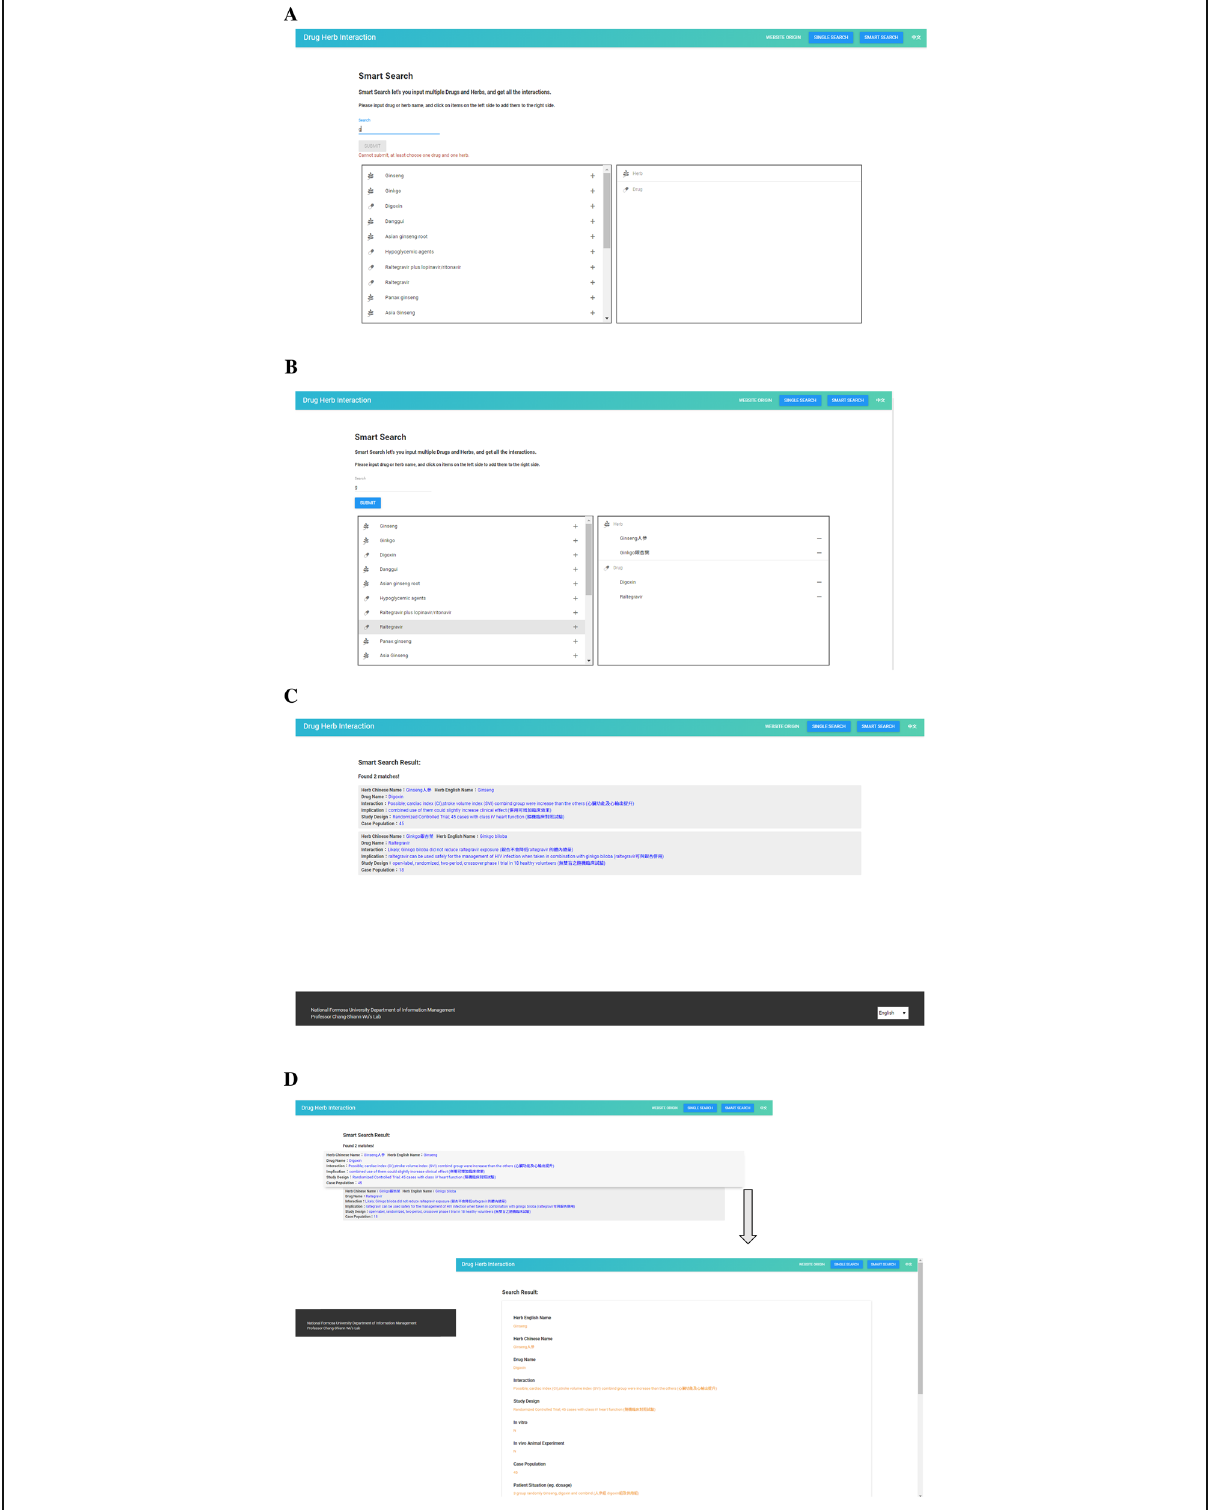
Fig. 3 a Smart search webpage. b One English letter “ g ” is input, and users can select the item of interest by clicking “ + ” to the right column; users can continuously click “ + ” for multiple selections of herbs and drugs, followed by clicking the “ submit ” icon to command the query. c Display of matched results lists. d Pointing out the HDI text box and clicking to pop out the selected monograph information for each